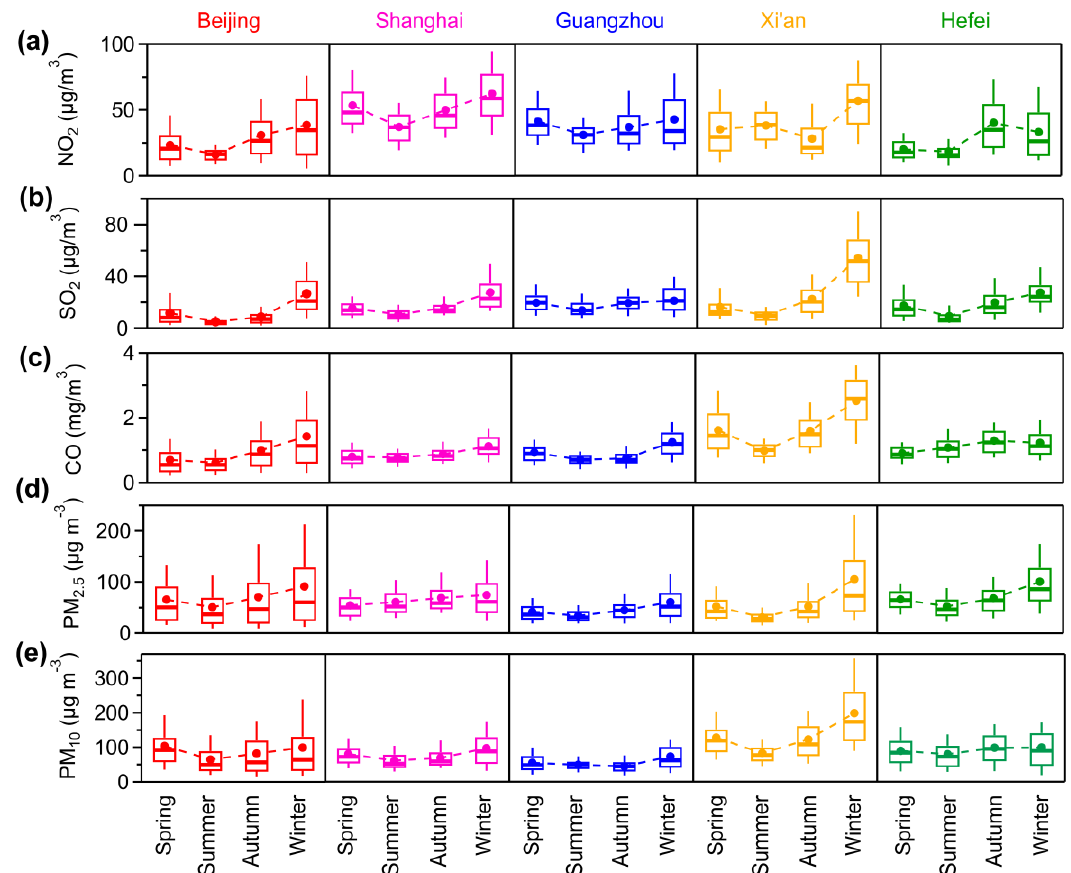
Figure 5. Seasonal variations of NO 2 ( a ), SO 2 ( b ), CO ( c ), PM 2.5 ( d ), and PM 10 ( e ) concentrations in the five cities. The boxes represent the 25th percentile (lower edge), median (solid line), mean (dot with das line), and 75th percentile (upper edge). The whiskers above and below the box indicate the 90th percentile and 10th percentile.